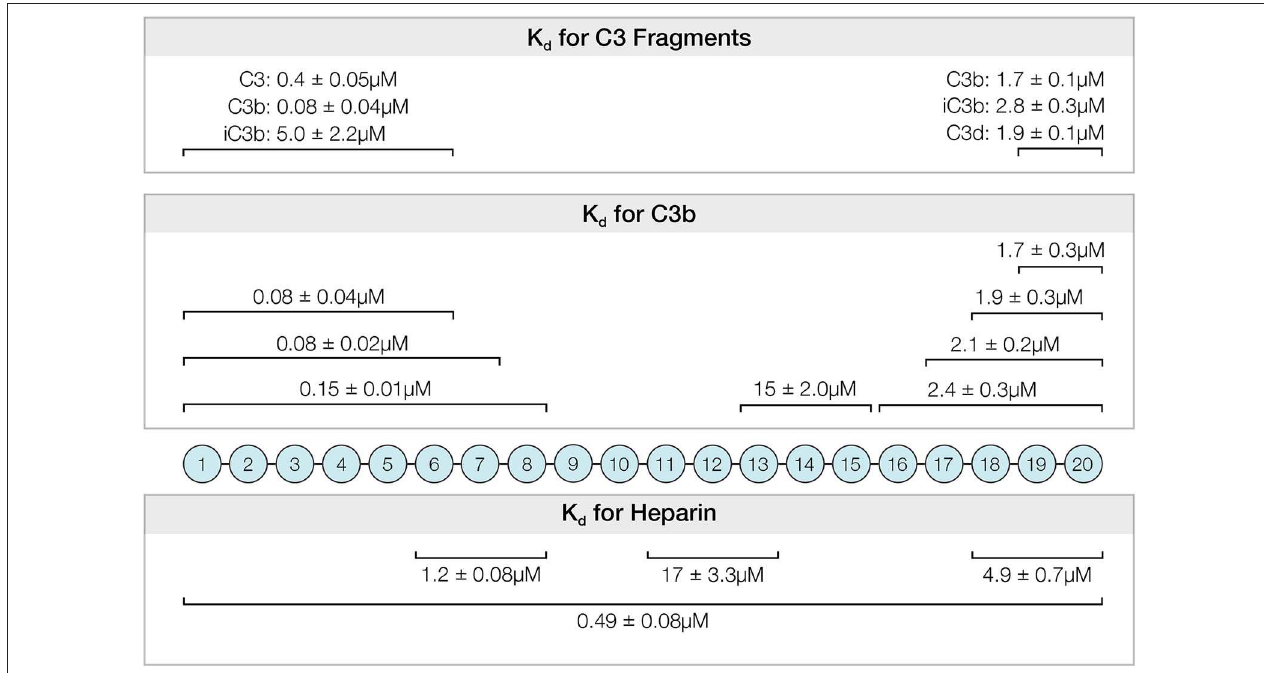
FIGURE 8 | Summary of affinities determined for the interactions between recombinantly expressed fragments of Factor H and C3, C3-derived proteins and heparin. The K d and standard errors for the interactions are given above the CCP domains of indicated fragments.